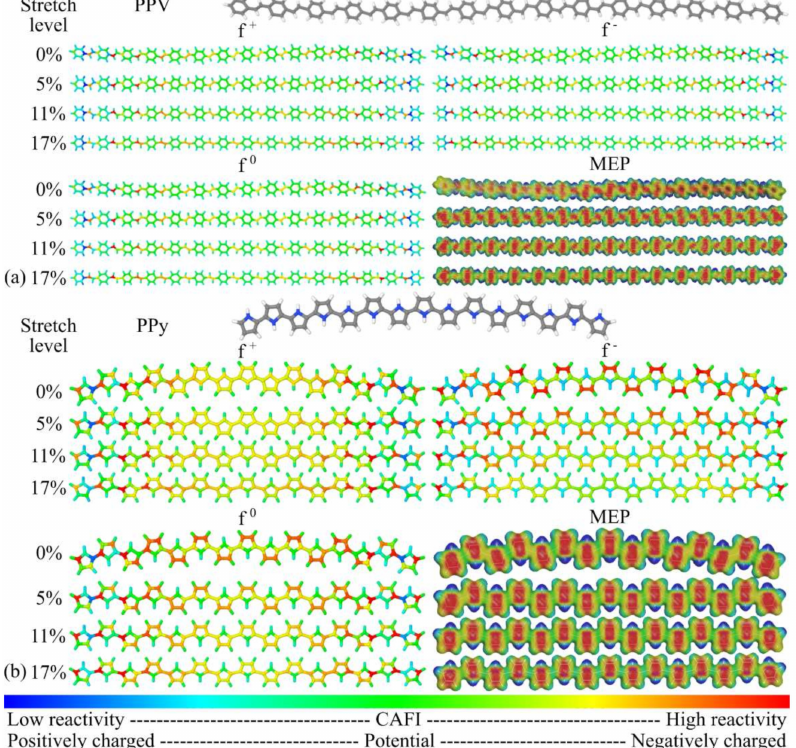
Figure 13. CAFI and MEP maps at distinct stretch levels: ( a ) PPV and ( b )